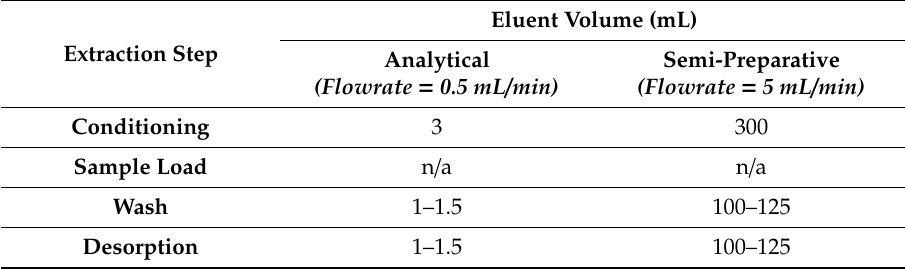
Table 1. General extraction steps for the adsorption and desorption of [DMPIm][NTf 2 ] ionic